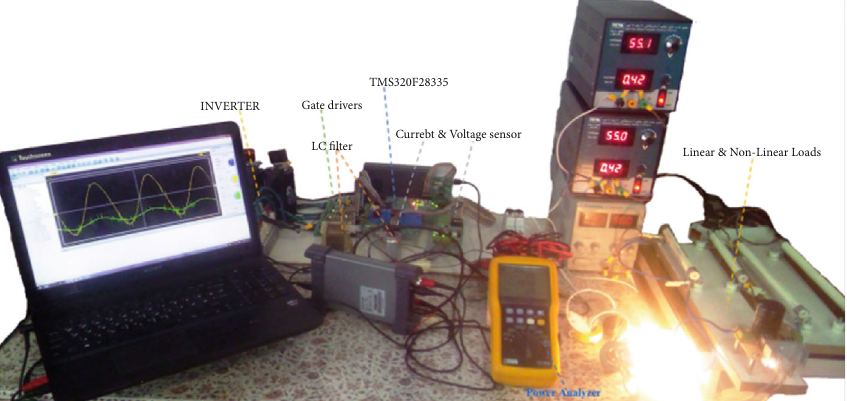
Figure 10: Γ u converter prototype.